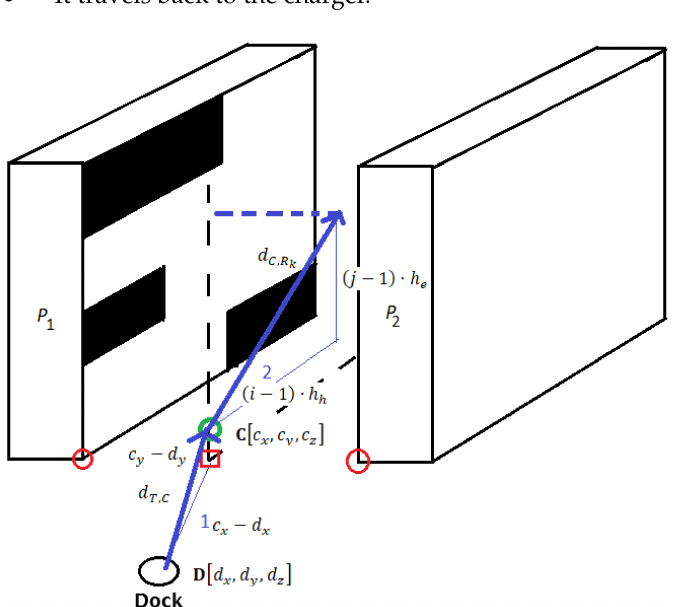
Figure 6. Route and guides. The green circle is the start position of the examination; the blue line is the route of drone; the red square is the center of the corridor (reference point). The red circles are referece points. (source: self-edited